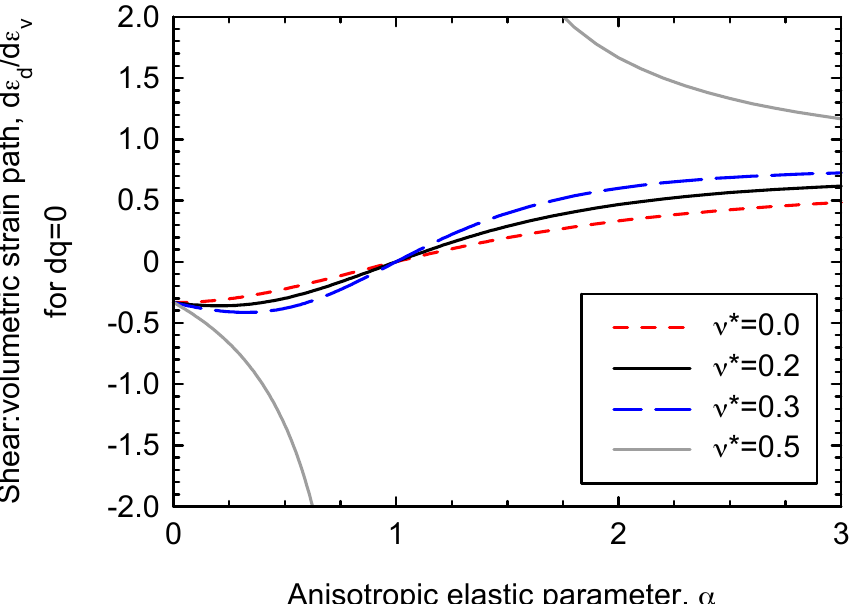
Figure 9. Strain path (ratio between shear and volumetric strains) for compression under constant shear stresses ( dq = 0 ).